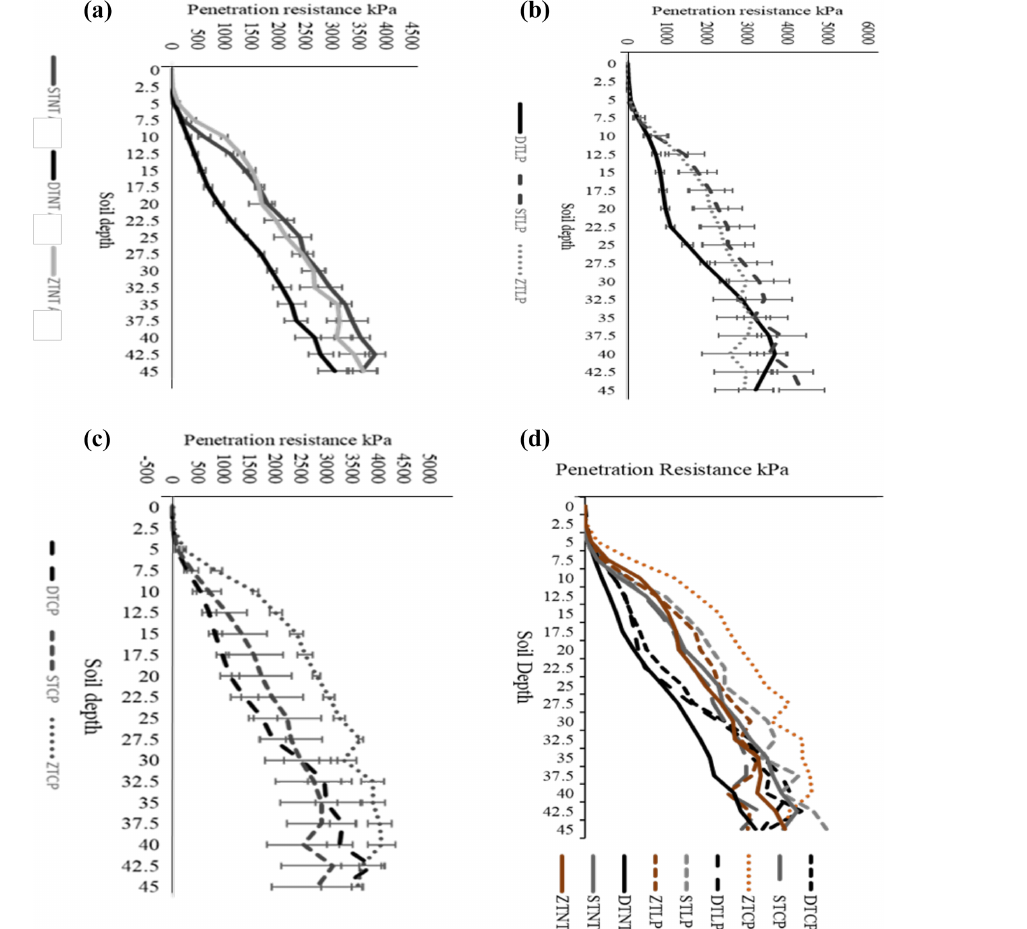
Figure 5. Penetration resistance (kPa) for tillage and traffic treatments at soil depths of 0–450mm. The x axis depicts soil depth, whereas the y axis depicts soil penetration resistance (kPa). Treatments are represented by initials. For tillage, the abbreviations for the treatments are D – deep, S – shallow, and Z – zero, while the abbreviated treatments for traffic are NT – no traffic, LP – low-pressure tyre, and CP – conventional-pressure tyre. Panel (a) shows no traffic, panel (b) shows low tyre pressure, panel (c) shows conventional tyre pressure, and panel (d) shows the traffic × tillage treatments